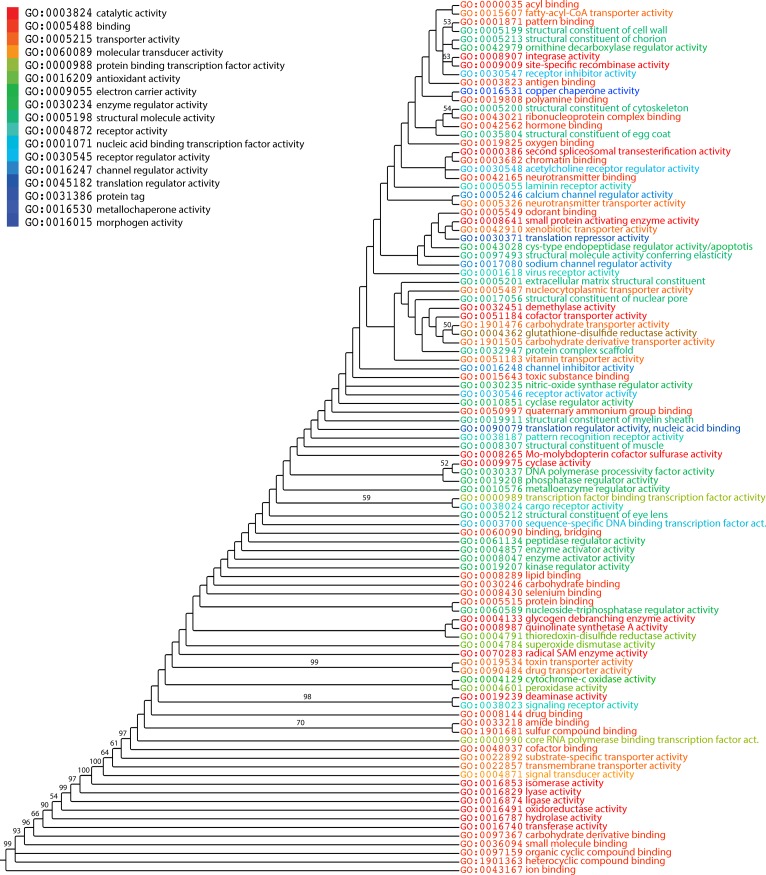
A ToF potraying the evolution of level 2 GO terms.Molecular functions are colored according to corresponding level 1 GO terms. Nonparametric BS values are shown above branches, which are supported by more than 50% of 1,000 replications. The tree was rooted by the Lundberg method. Tree length = 12,363; RI = 0.92; CI = 0.46, Hi = 0.53; and g1 = -0.67.